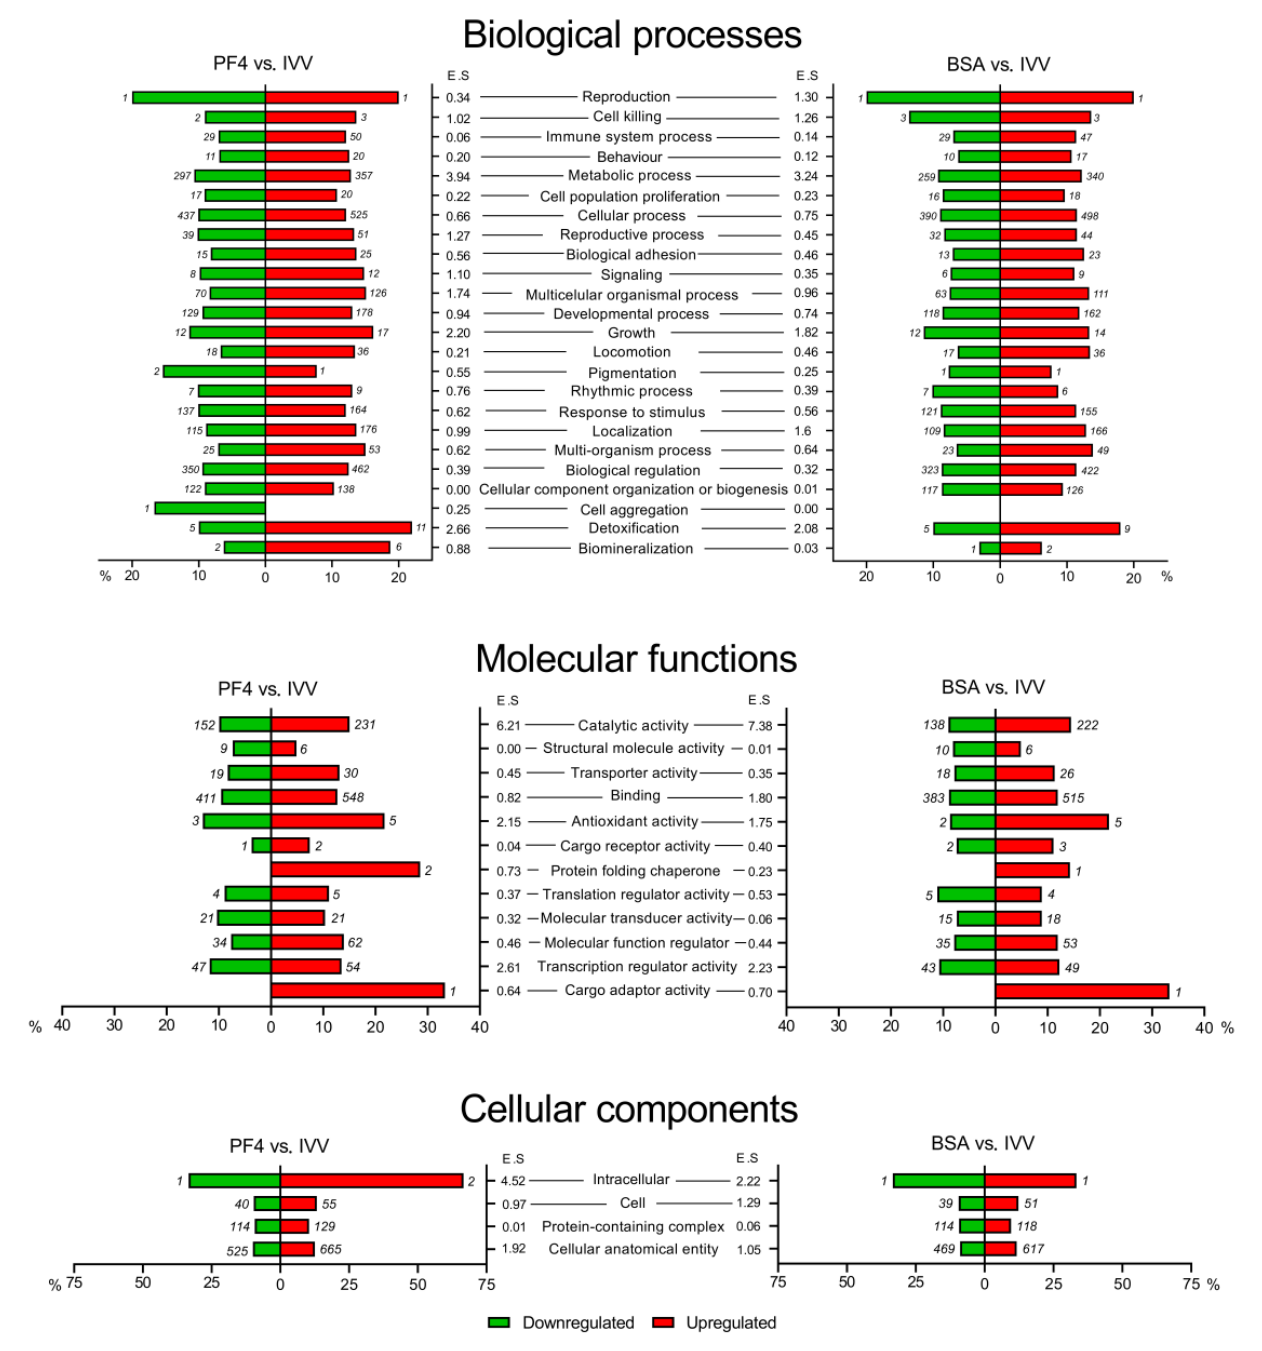
Figure 4. Classification of differentially expressed genes (DEG) organized by gene ontology (GO)-terms. The lists of DEG were obtained after comparing the in vitro embryos cultured in defined media (PF4: platelet factor 4) versus the in vivo-derived embryos (IVV), and the in vitro embryos cultured in undefined media (BSA: bovine serum albumin) versus the IVV embryos. In each forest plot, the X -axis represents the percentage of DEG out of the total number of genes belonging to each category. Green bars represent the percentages of downregulated DEG, while the red bars indicate the percentages of upregulated DEG. Next to each bar, the number of upregulated (red bar) or downregulated (green bar) DEG, belonging to that GO-term is indicated. ES: enrichment